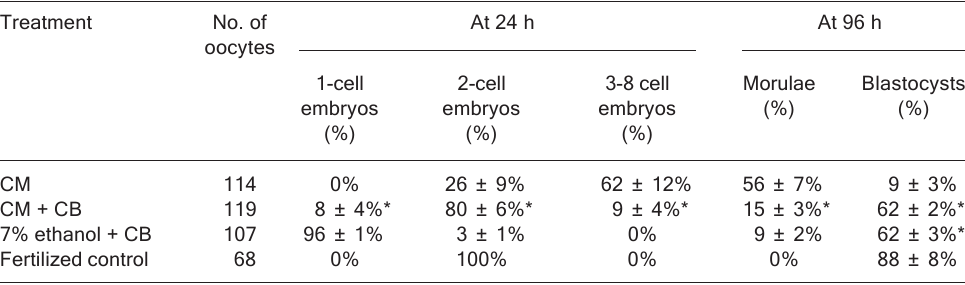
Table 3. Development of activated mouse oocytes cultured in vitro in CZB medium.